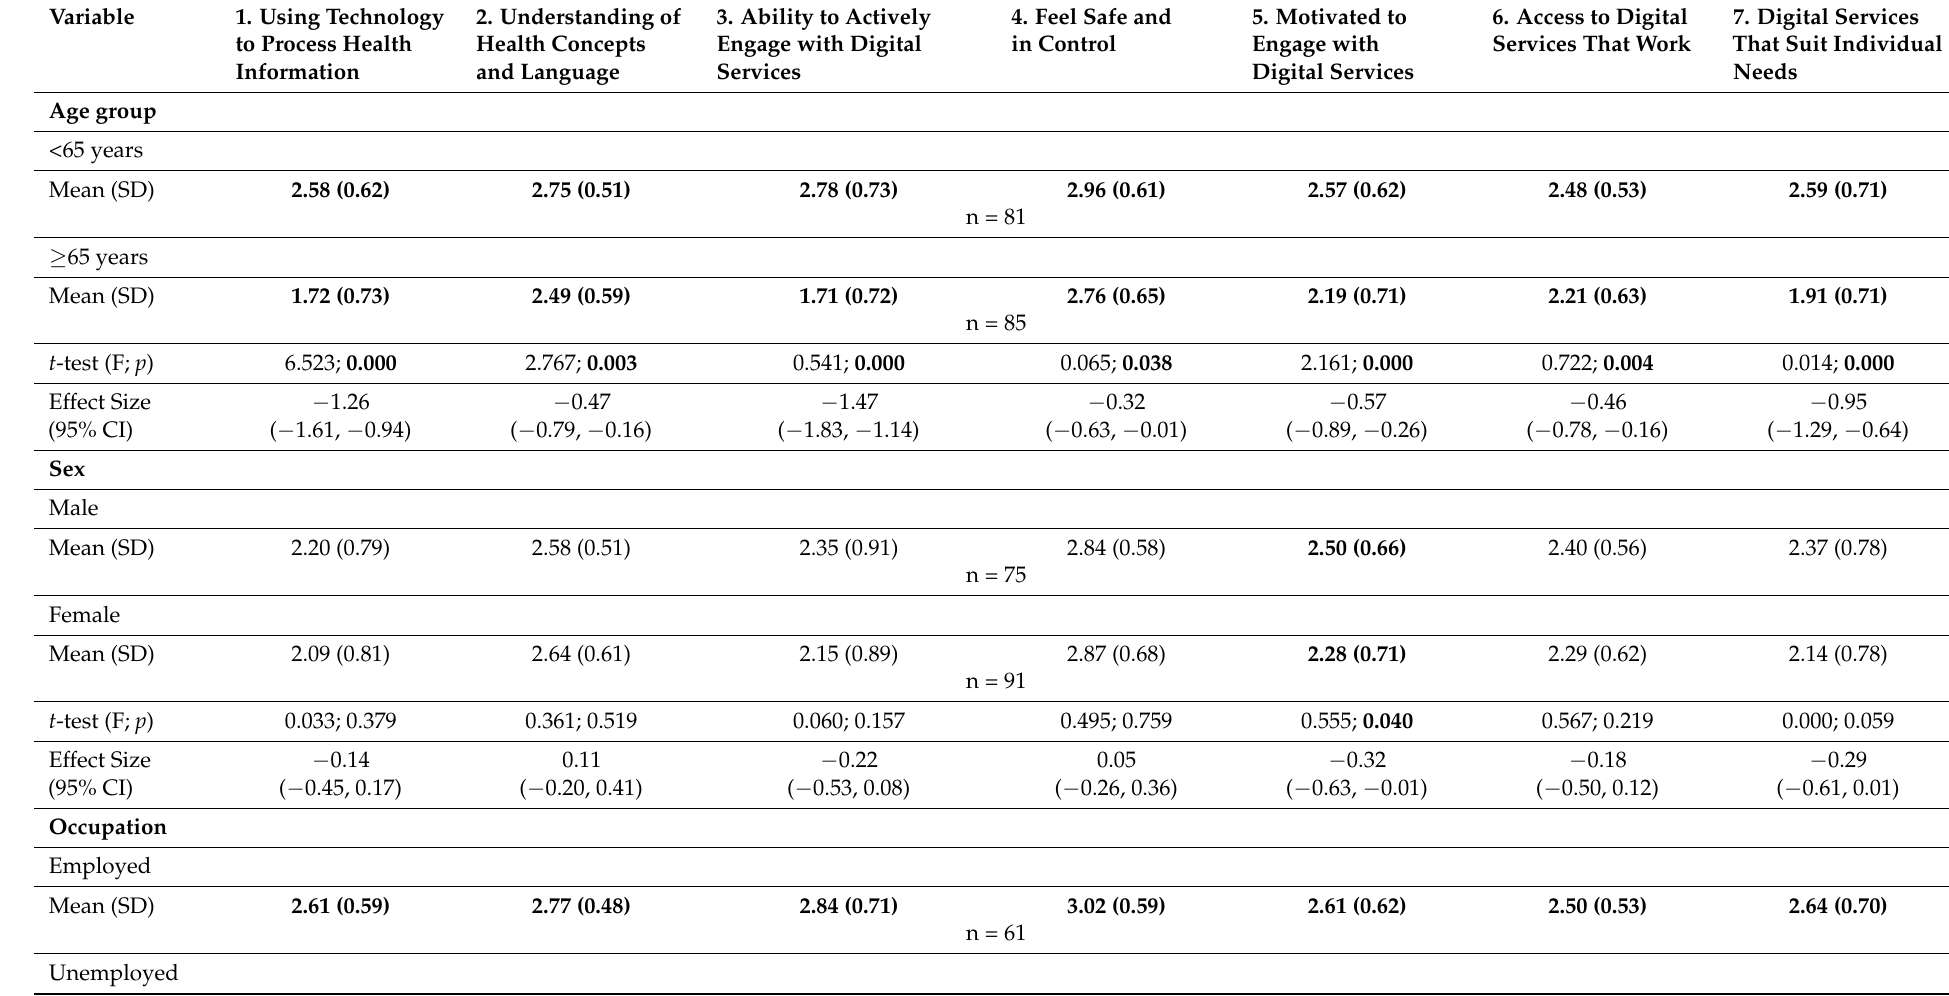
Table 1. Associations among sociodemographic factors and eHLQ